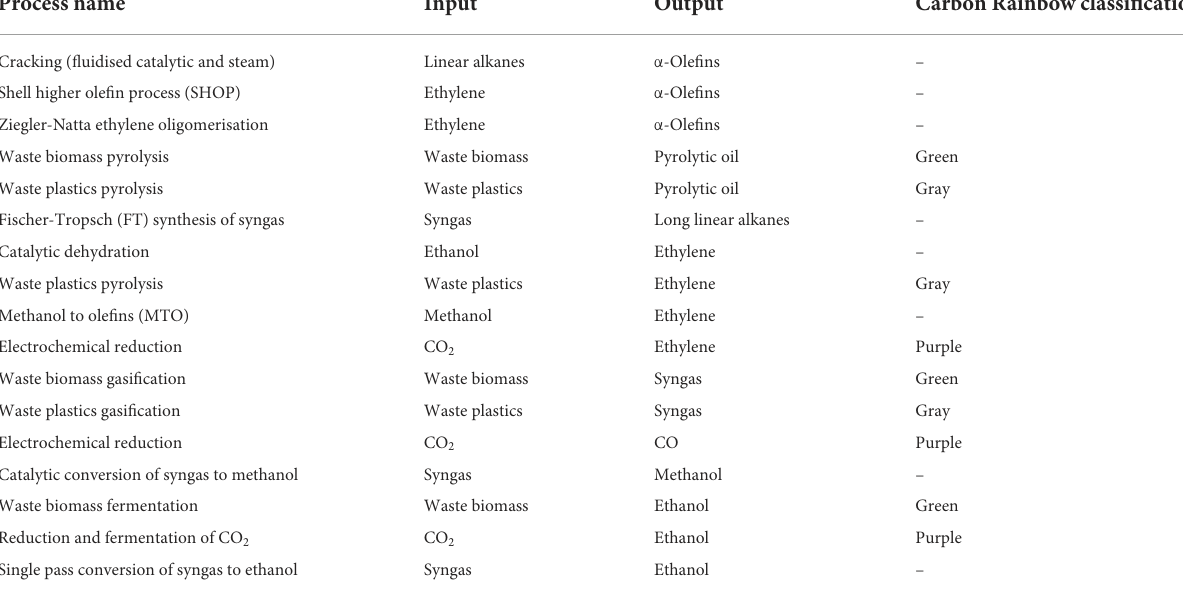
TABLE 4 Summary of processes included within this review (in order of